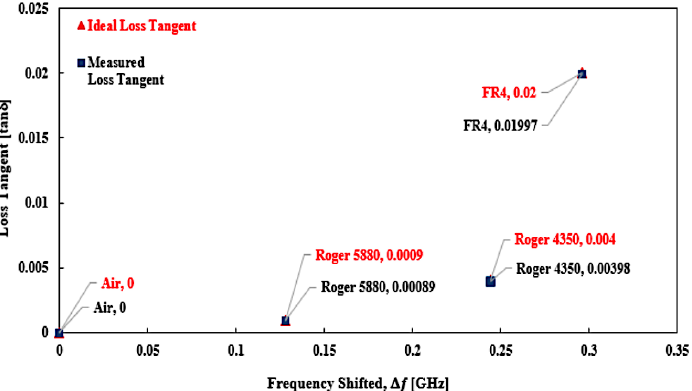
Figure 19. Comparison of the ideal and measured loss tangent of several SUTs (solid).